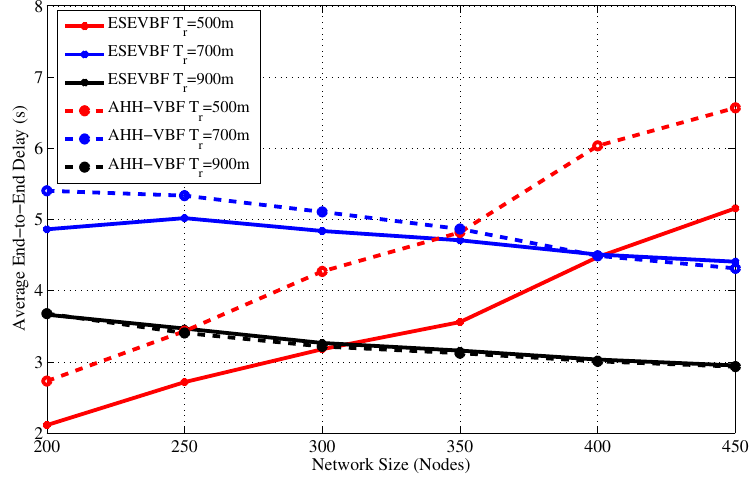
Figure 8. End-to-End delay between Source node that generated data message and Sink node versus the network size.